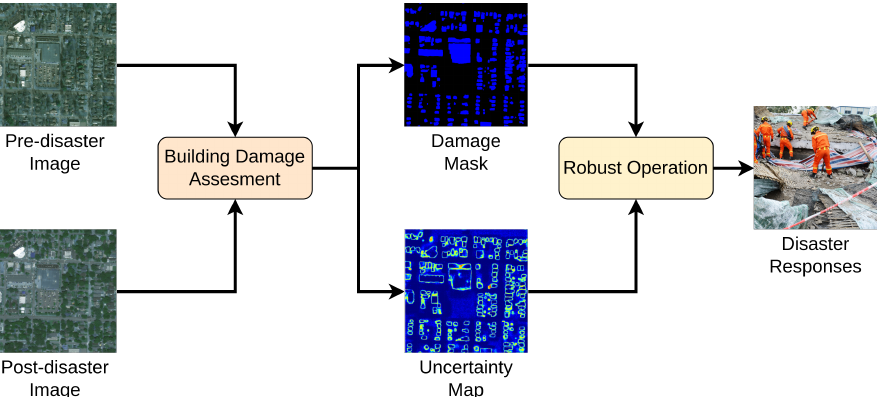
Figure 2. The illustration of the proposed efficient and uncertainty-aware decision support sys- tem